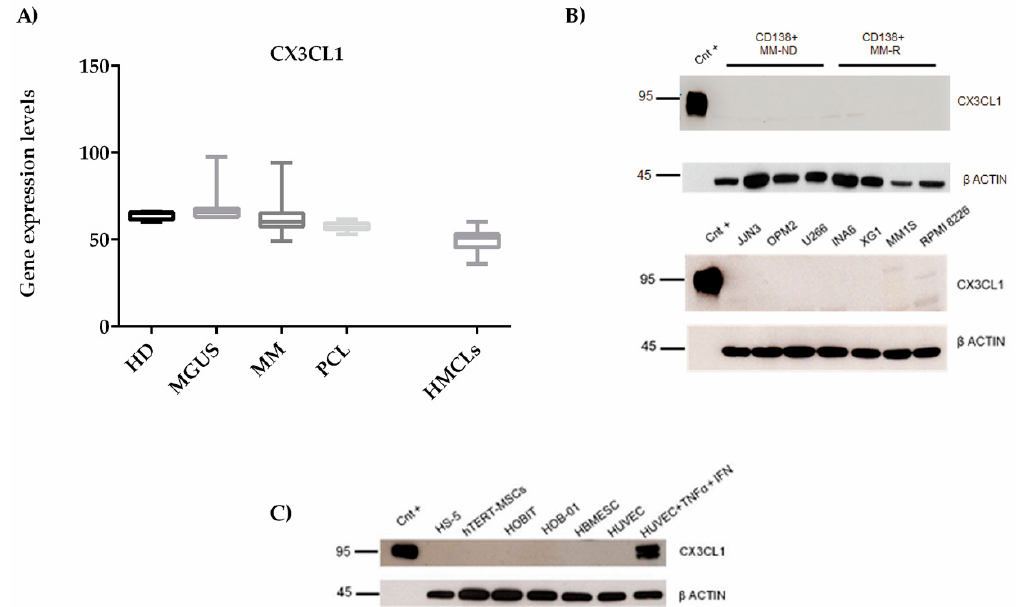
Figure 3. ( A ) CX3CL1 expression by MM cells. Box plots of the expression levels of CX3CL1 mRNA in CD138 + cells obtained from 4 HD, 11 MGUS, 133 MM patients, 9 PCL (GSE16122), and 23 HMCLs (GSE6205). ( B ) The expression of CX3CL1 protein was evaluated in eight purified BM CD138+ ( upper ) samples from four MM-ND and four MM-R patients and in seven HMCLs ( lower ) by western blot (positive control (Cnt+): Recombinant CX3CL1). ( C ) The western blot represents CX3CL1 protein expression on microenvironment cell lines. MM-ND—newly diagnosed MM; MM-R—relapsed